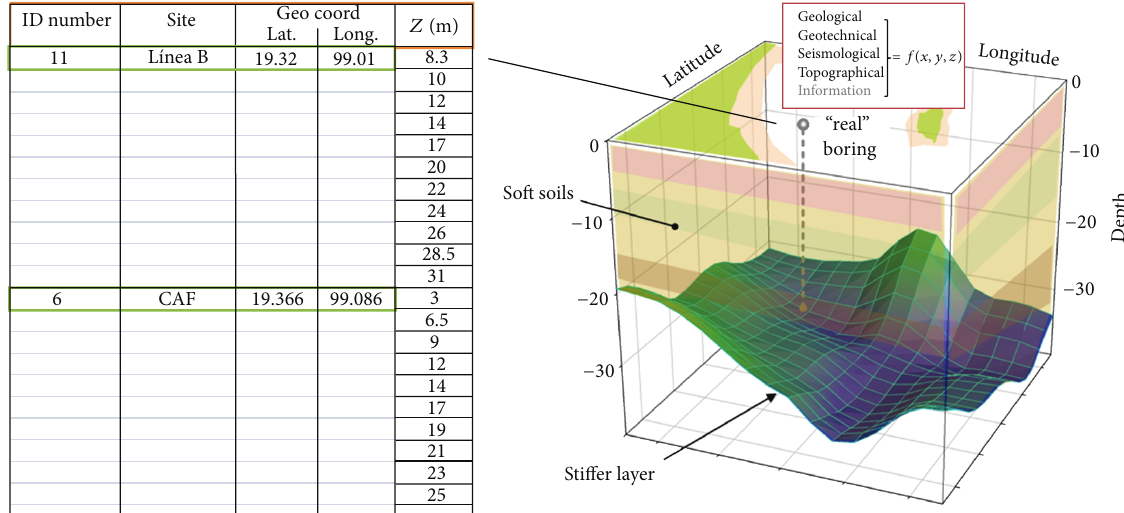
Figure 3: Schematic representation of Table 1: “real” borings